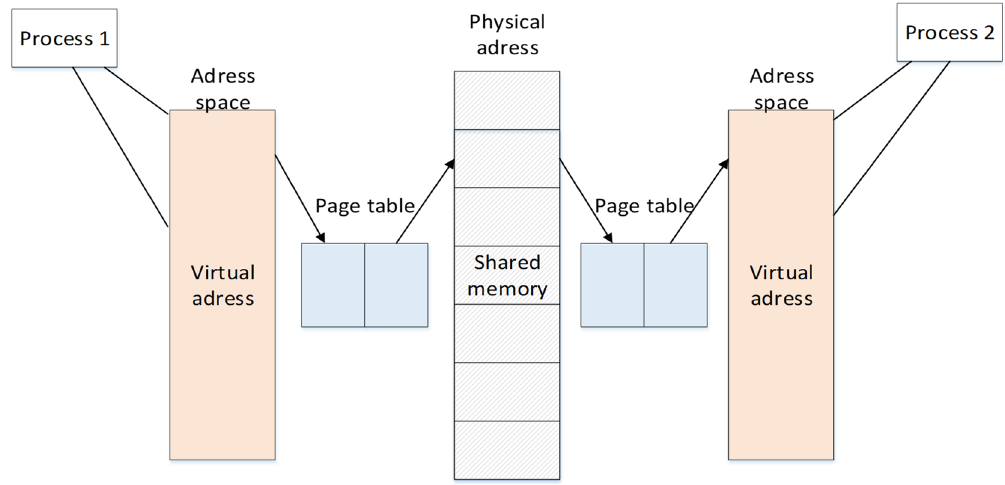
Figure 8. Basic communication process of shared memory.